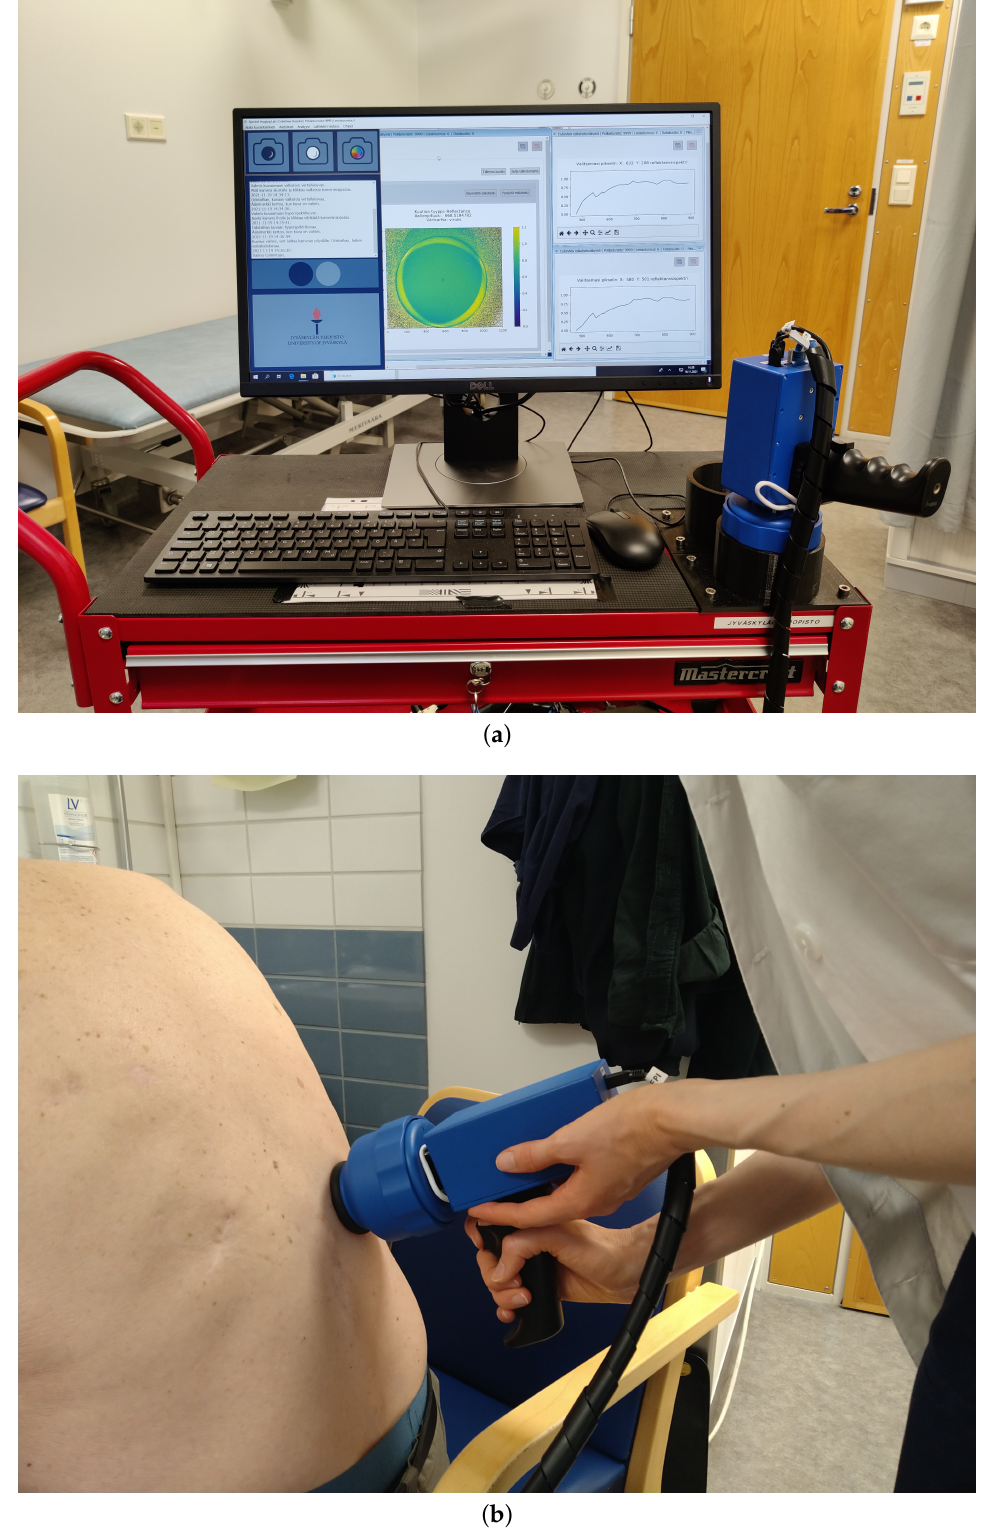
Figure 11. SICSURFIS imaging system. A handheld image sensor and a small computer for data col- lection are attached to a trolley that can be moved around hospital wards. Subfigure ( a ): SICSURFIS imaging system. Subfigure ( b ): SICSURFIS HSI in clinical